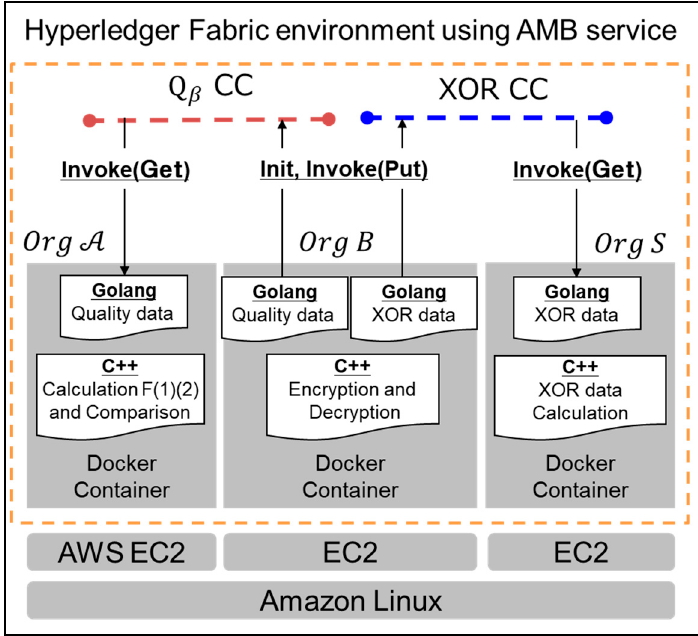
Figure 4. Configuration of proposed the B2B collaboration system.